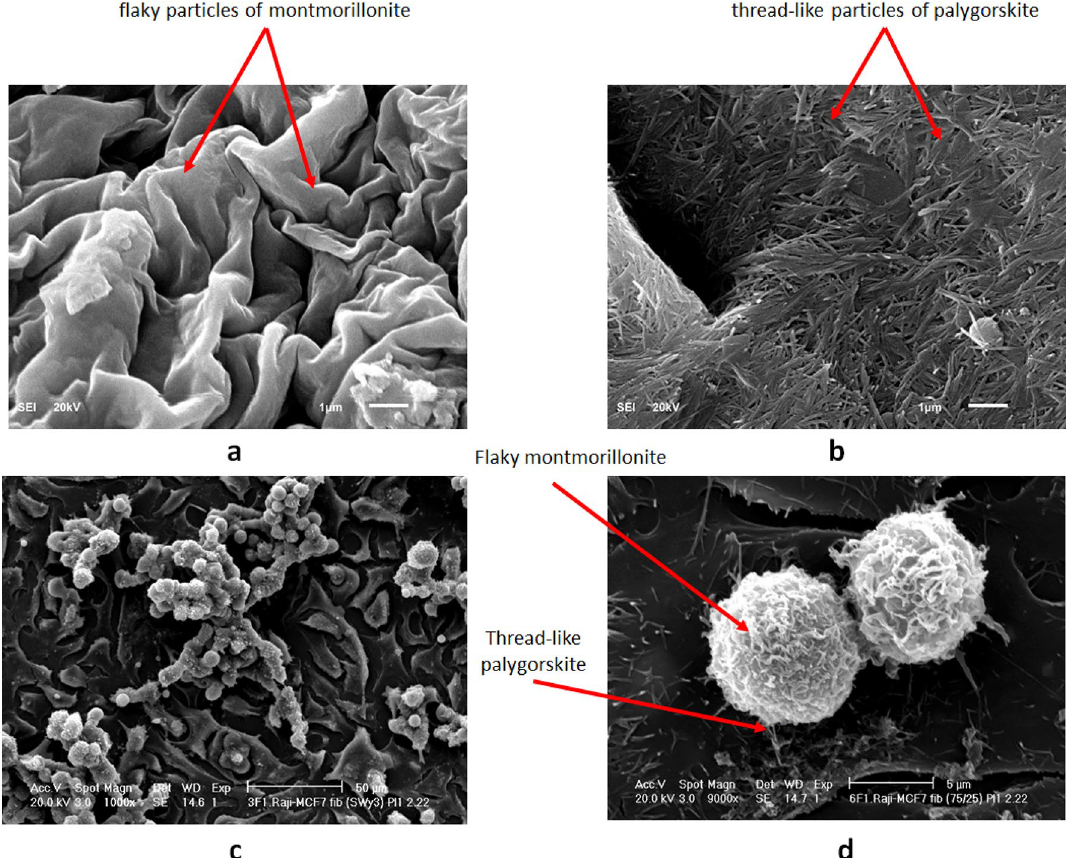
Figure 6. SEMs of the nano-clays and cancer cells interaction. ( a ) Na-montmorillonite flaky particles. ( b ) Thread-like Palygorskite particles. ( c ) Na-montmorillonite/Palygorskite particles enveloping/binding the multiple cancer cells. ( d ) Close-up view of couple of cancer cells enveloped by the clays. In contrast, the absence of any such free adhesion force does not promote any such adherence in case of healthy cells. This also supports the conclusion that other processes leading to the inhibition of cell proliferation and necrosis would also be absent in case of healthy cells, and nano-clays do target cancer cells only. This fact is further explained in the light of the non-toxicity of the clays to healthy human cells in the section on the compat- ibility of the nano-clays with the healthy human cells. Based on the possible physical interactions, a schematic interaction model of nano-clays and the cancer cells have been prepared and shown in Fig. 7. Authors concluded in their previous study that adhesion processes are facilitated by the van der Waals, electrostatic, and zeta potential (ZP) attractions 30 . Zeta potential is the charge on a particle at its shear plane along the diffuse double layer when present in suspension. It helps in understand- ing and predicting the interactions between particles during suspension such as dispersion, agglomeration, etc. Generally, if ZP of a material is greater than 30 mV (either positive or negative), it designates its tendency to disperse. On the other hand, a ZP value of lesser than five mV indicates the tendency of material to aggregate in the interaction probability with the tumour cells. Although considering their ZP values, Na-montmorillonite nanoparticles are categorized as hydrophilic in nature, they generate a secondary adhesion with the hydrophobic they also demonstrate higher dispersion tendencies owing to both the hydrophilic nature and relatively higher acid–base (AB) repulsion forces. This dispersion tendency leads to generation of higher surface area and hence in the increased attractive interactions. Palygorskite due to their higher surface area of 136 m 2 /g, results in greater attractions due to the van der Waal attractions and the electrostatic forces. On the other hand, Na-montmoril- lonite has a relatively lesser surface area (32 m 2 /g), but they also get attracted to the negative cell surfaces through their positively charged edges. The optimized proportion of Na-montmorillonite and palygorskite (75/25) used in this study primarily owes to the maximum adhesion caused by this proportion (Fig. S6) as compared to the other proportions. Moreover, due to almost same surface area of each of the component at this proportion (75/25) results in the maximization of the contribution of the each type of nano-clay. At this proportion, Na- montmorillonite is providing maximum coating, while palygorskite is resulting in maximum bridging action. In addition to the above-explained interaction mechanisms, attractions also exist among the dispersed sodium/calcium cations from the clay dispersed as colloids in PBS medium, and the negatively charged cell